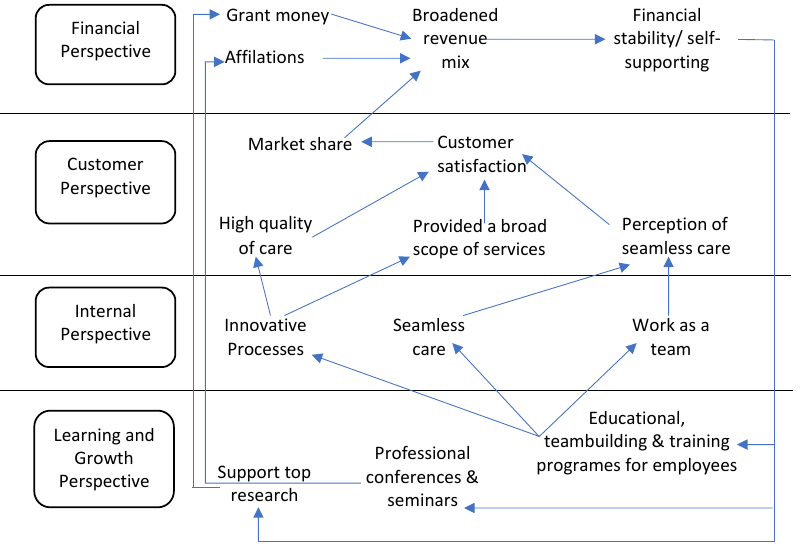
Figure 2. Duke University health system strategic map [15].